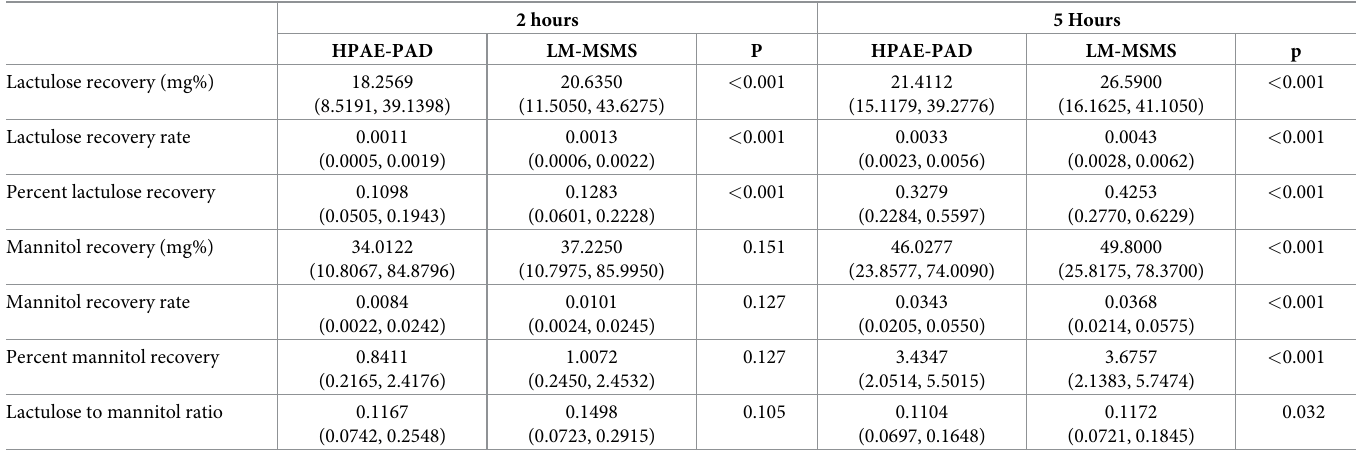
Table 2. Summary of lactulose and mannitol excretion in 2 hours and 5 hours urine collection.